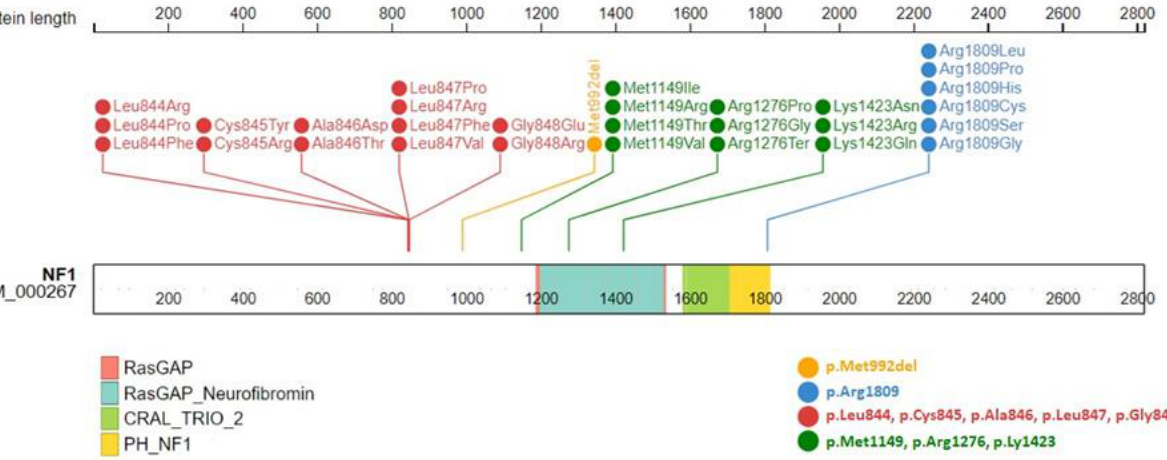
Figure 6. Graphical distribution of NF1 missense variants currently associated with different classes of mild to severe phenotypes: deletion of methionine 992 (orange); six different substitutions of arginine 1809 (blue); 14 substitutions involving leucine 844, cysteine 845, alanine 846, and glycine 848 (red); 13 substitutions of methionine 1149, arginine 1276, and lysine 1423 (green). All these variants were annotated in Clinvar and refer to the NM_000267.3 isoform.